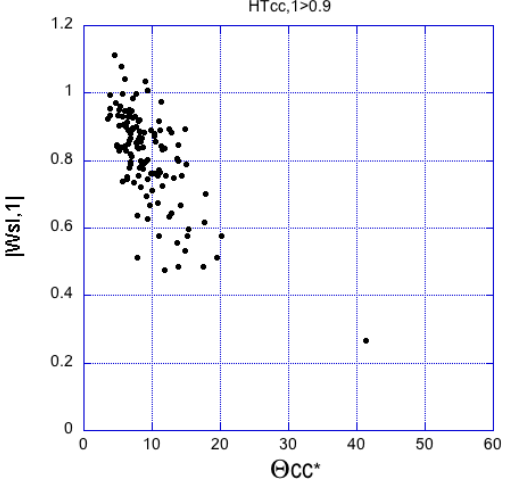
Fig. 6. Scatterplot of the Wal ´ en slopes and angles 2 ∗ cc for the cases with HT cc , 1 ≥ 0.9, for the 1min center